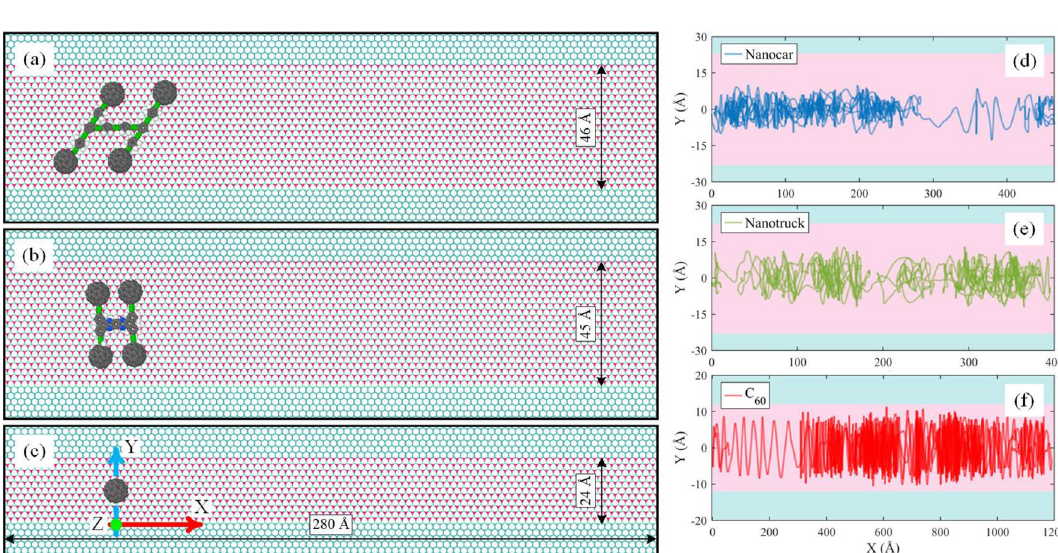
Figure 6. The initial condition of the simulation of a ( a ) nanocar, ( b ) nanotruck, and ( c ) C 60 on the boron- nitride nanoroad. Different simulation systems were considered to study the unidirectionality of motion. Trajectories of ( d ) nanocar, ( e ) nanotruck, and ( f ) C 60 on the nanoroad during 15 ns of simulation at 300 K. The blue and pink parts of each figure indicate the sections of graphene and boron-nitride substrate,